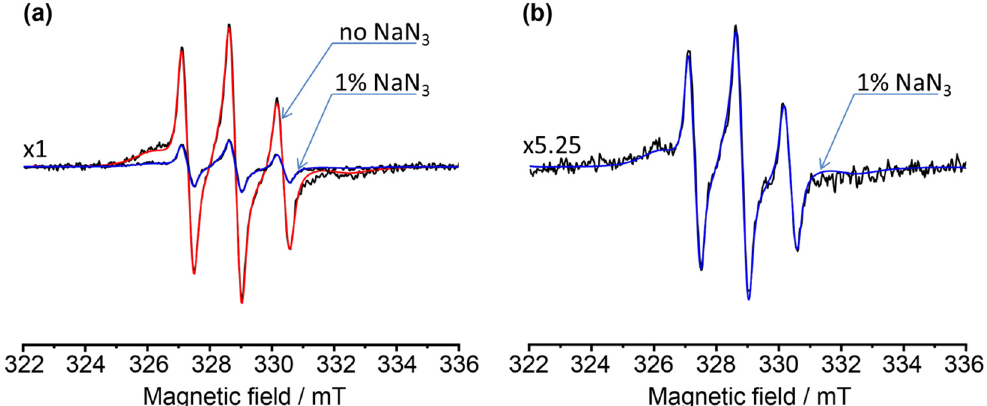
Figure 7. Black: Experimental EPR spectra of A549 cells after their incubation with 1.34 µ M sRL2 (molar ratio of spin label 1 to RL2 2 : 3.5) with and without the addition of 1% NaN 3 . ( a ) The comparison of the two experimental spectra acquired at 1.02 h (correspondent to no NaN 3 ) and at 0.97 h (correspondent to 1% NaN 3 ) from the end of the cell incubation with the same sRL2 concentration. ( b ) The same spectrum correspondent to 1% NaN 3 presented on ( a ) with a magnification of 5.25 times. Red and Blue: Simulation of the experimental spectra that is carried out by means of the three EPR spectral components discussed above with their second integral weight ratios (1):(2):(3) at 0.69:0.28:0.03 (Red, no NaN 3 ) and 0.72:0.23:0.05 (Blue, 1% NaN 3 ).